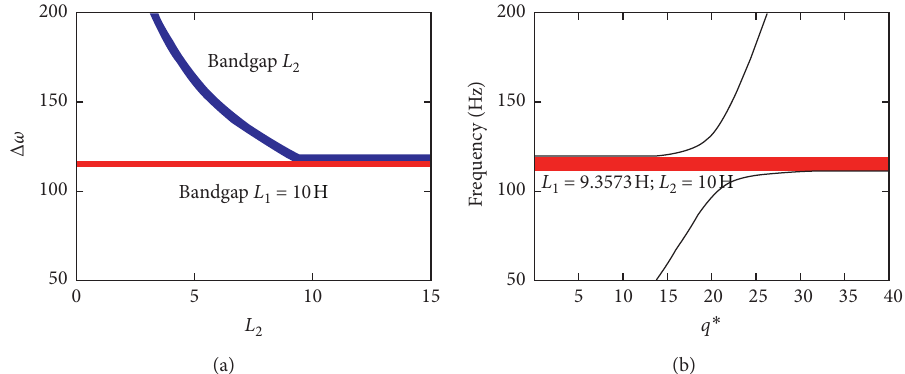
Figure 5: The locally resonant band structure of the metamaterial beam in pure inductance circuit with (a) L (b) L 1 � 9.3573H and L 2 �